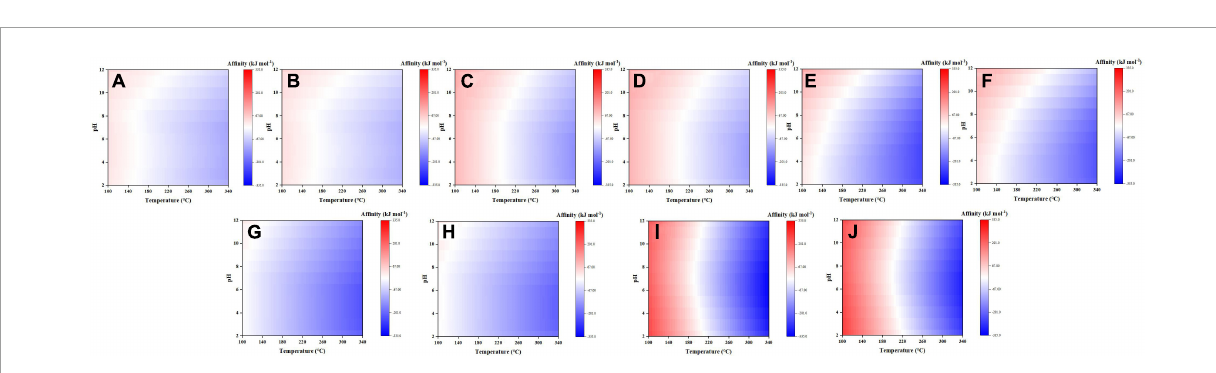
of the studied compounds. For example, formaldehyde, which has negative synthesis affinities in a wide range of temperatures under the referenced redox condition ( Figure 2C ), becomes